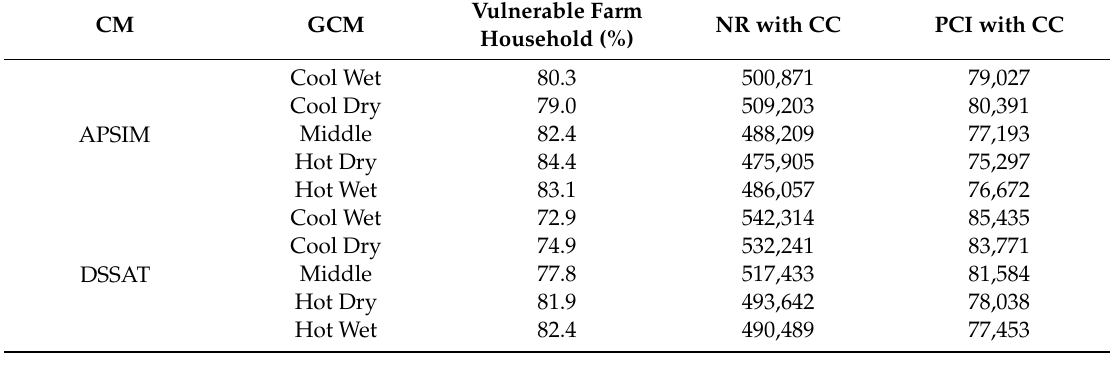
Table 7. Climate change impact on socio-economic factors in aggregate data for RCP 8.5.